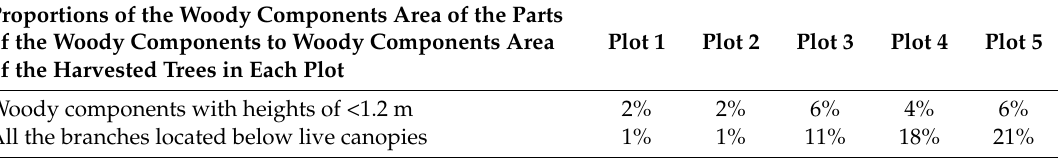
Figure 4. The proportion of stem, branch, and fruit area to the woody components area of each harvested tree in the five plots, respectively (S: stem, B1-B6: levels 1 to 6 branches, respectively, and F: fruit). ( a ): plots 1 and 2, ( b ): plots 3 and 4, ( c ): plot 5. Table 3. Proportions of the woody components area of those woody components with heights of <1.2 m (including stem and branches) or the branches located below live canopies to the woody components area of the harvested trees in each plot.